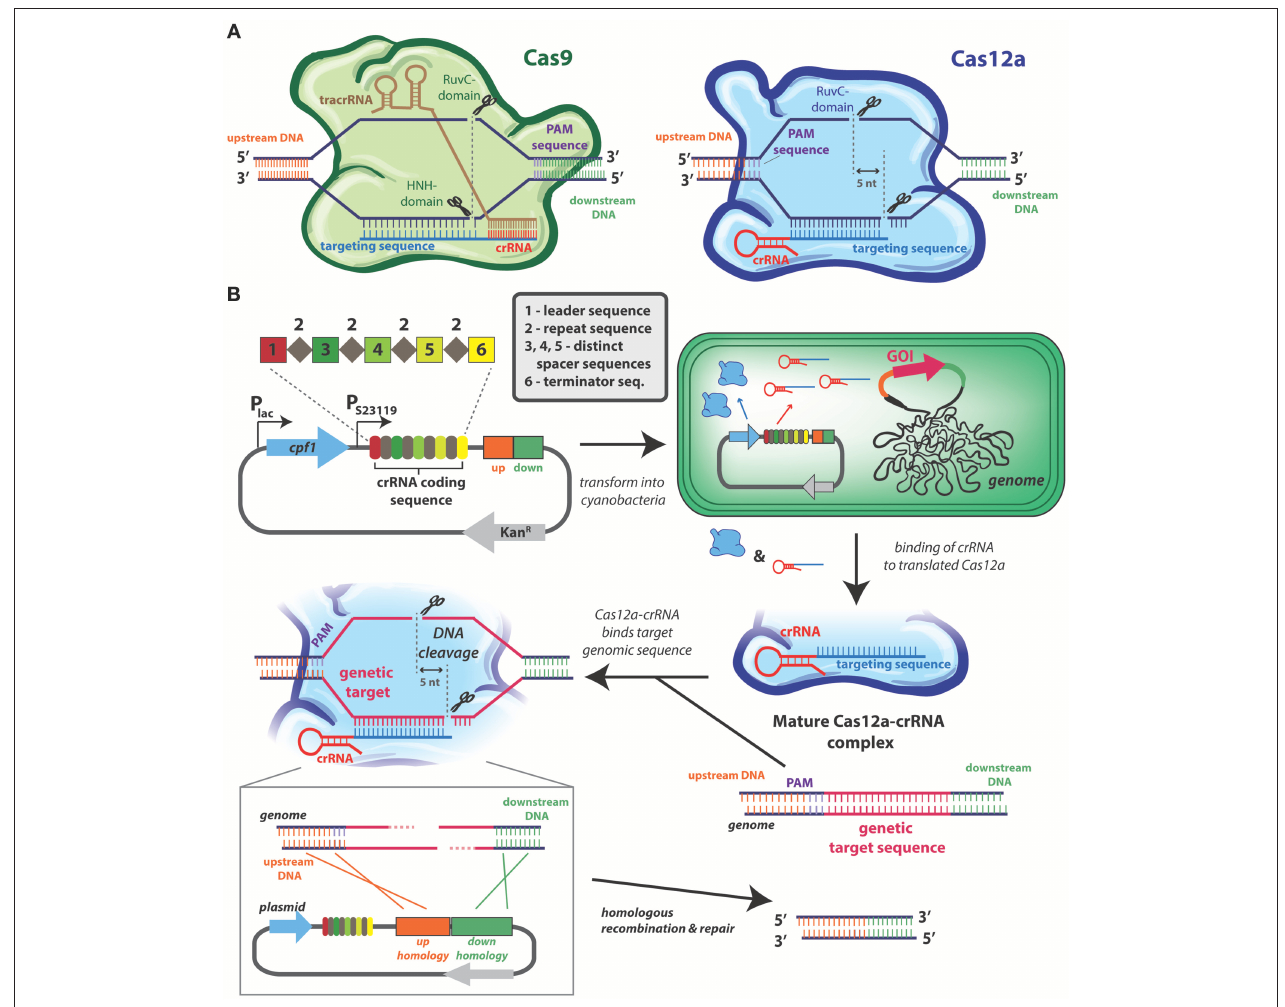
FIGURE 2 | CRISPR- cas technologies used for genome editing of cyanobacterial genome. (A) CRISPR- cas systems used in cyanobacteria: Cas9 (left) and Cas12a (right). In type II systems, Cas9 (green) forms a complex with the crRNA (red) and tracrRNA (brown), whereas in type V systems, Cas12a (blue) forms a complex with its crRNA (red). Both nucleases identify their target sites on the basis of complementarity of the guide sequence (blue) by heteroduplex formation, as well as the presence of a neighboring protospacer-adjacent motif (PAM; purple), although the positioning of the PAM is distinct between systems Cas9 cleaves the complementary DNA strand using its HNH domain, and a second RuvC domain to cleave the non-complementary strand. Cas12a cleaves target DNA using one RuvC endonuclease domain, and a second endonuclease activity is attributed to a novel nuclease domain. (B) Example application of CRISPR/Cas12a in Synechococcus elongatus PCC 7942. This system is based on the use of a single plasmid that contains: the cas12a gene under the lac promoter and a crRNA-encoding array (from Francisella novicida ) under a constitutive (J23119) promoter. This plasmid allows for inducible, transient expression of cas12a . This crRNA-encoding array contains a leader sequence (1) followed by direct repeat (2) and spacer (3, 4, 5) sequences, and a terminator (6). In most cyanobacterial CRISPR-Cas reports a single spacer region (e.g., number 3) acts as the genome target spacer, while other spacers are not utilized. Multiple genomic regions can be targeted by encoding other spacers with complementary sequences, or the efficiency of modifying a single genomic loci can be improved by utilizing multiple spacers (Niu et al., 2018). Homology regions designed to promote recombination-mediated repair can also be encoded in the plasmid (represented by orange and green rectangles). Once inside the cell, an active and mature Cas12a-crRNA complex forms and is directed to the target sequence. After the introduction of the 5-nt staggered double-stranded break, the homology regions in the plasmid serve as a repair template to introduce the intended genomic changes. The transconjugants are selected on BG11 agar plates supplemented with kanamycin. The positive colonies are streaked on BG11 agar plates to cure the plasmid and they are assayed to check the loss by the inability to grow on kanamycin-containing media. Depicted system is modeled after the one described by Ungerer and Pakrasi